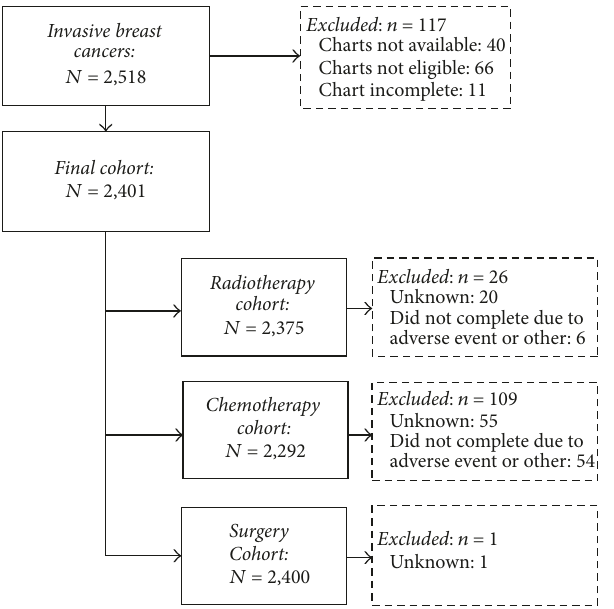
Figure 1: Cohort of women aged 50–69 diagnosed with screen- detected invasive breast cancer within the Ontario Breast Screening Program between January 1, 2006, and December 31, 2009.